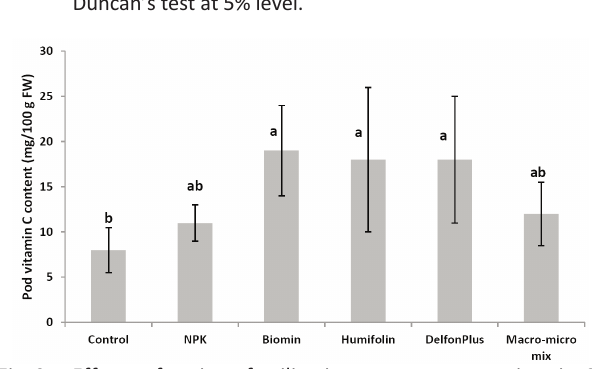
level.Fig. 2 - Effects of various fertilization treatments on vitamin C content of French bean pods. Data are mean of four repli- cates ± SD. Comparison of means was done using Duncan’s test at 5% level.